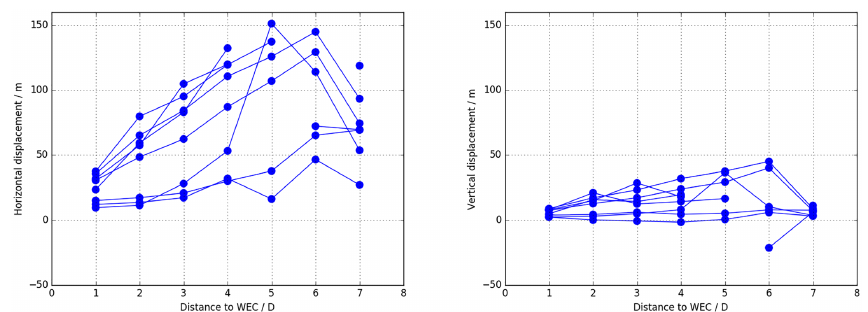
Figure 12. Averaged misalignment of the determined wake center to the beam-crossing measurement point.